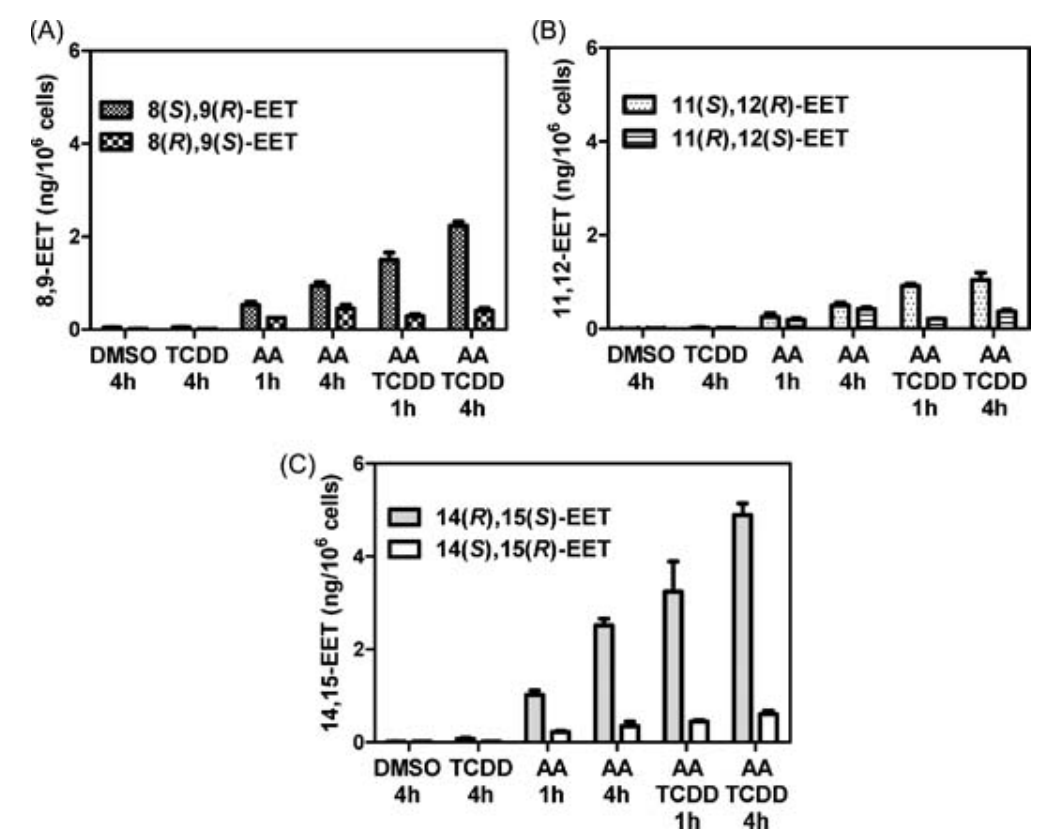
Figure 10. Analysis of epoxyeicosatrienoic acids by chiral liquid chromatography/electron capture atmospheric pressure chemical ionization mass spectrometry using a [ 13 C] ‐ analog internal standards. Reprinted with permission from Ref.